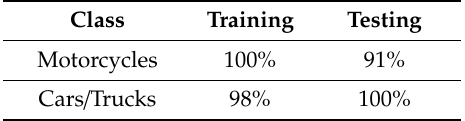
Table 3. Cars / trucks and motorcycles training and testing prediction accuracy.